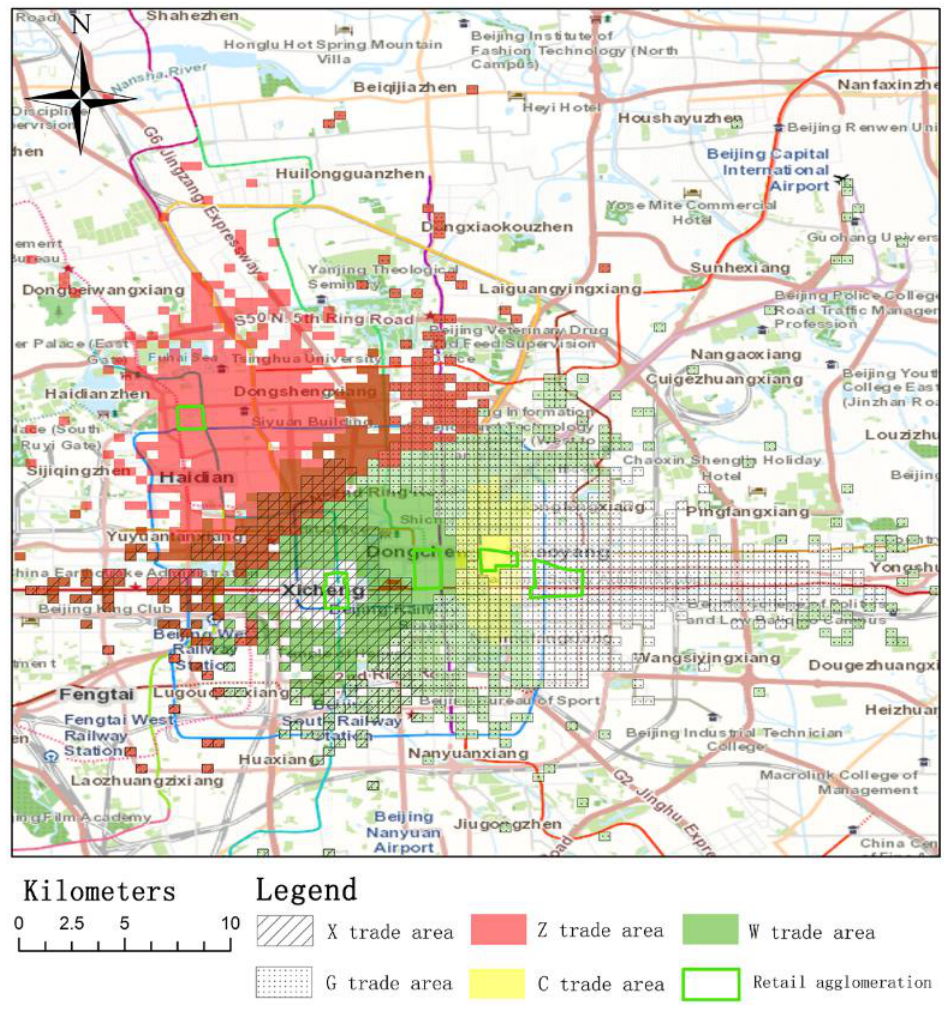
Figure 6. The overlap of different trade areas.